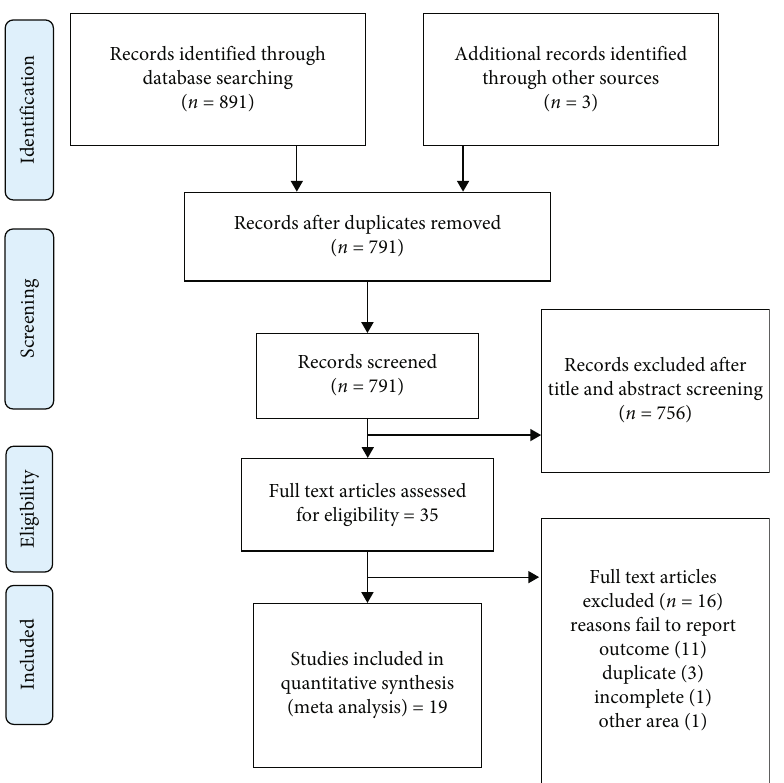
Figure 1: Literature search results and study